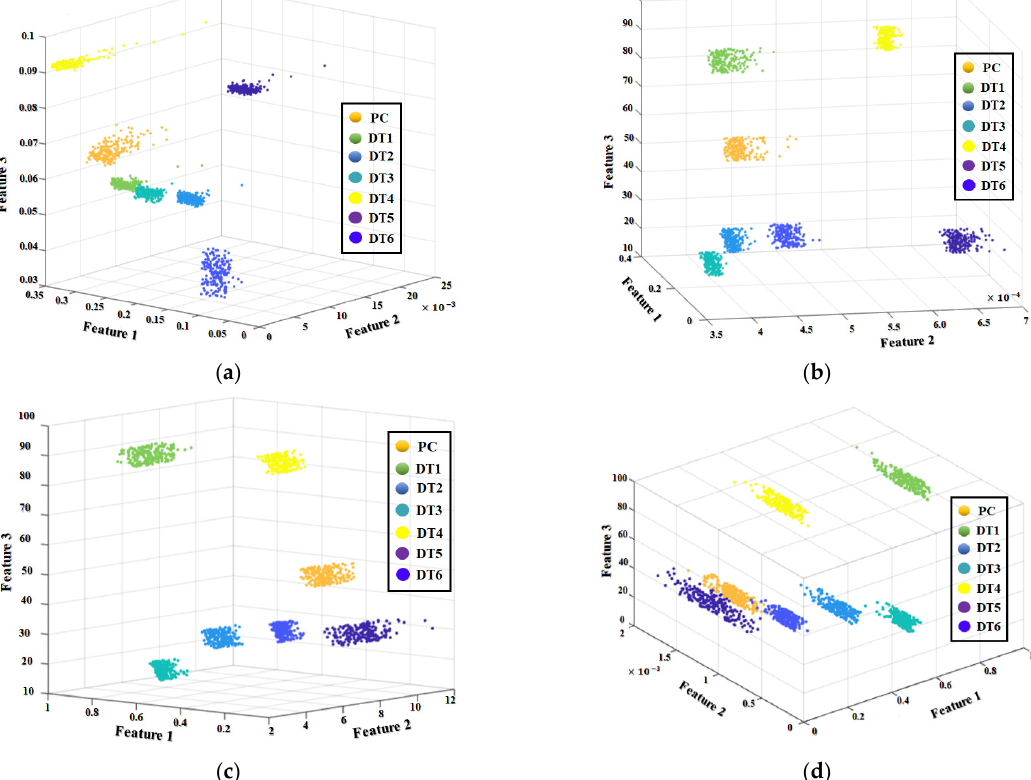
Figure 13. Three-dimensional clustering spaces of the four experiments: ( a ) Experiment 1, ( b ) Experiment 2, ( c ) Experiment 3, ( d ) Experiment